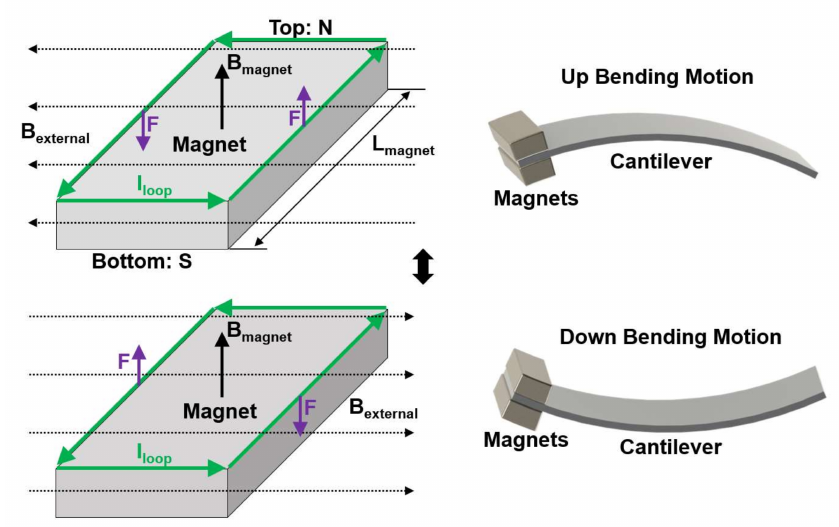
Figure 3. Schematic for mechanism of mechanical vibration on MME cantilever with counterclockwise and clockwise toque on mass magnets under external AC magnetic field.